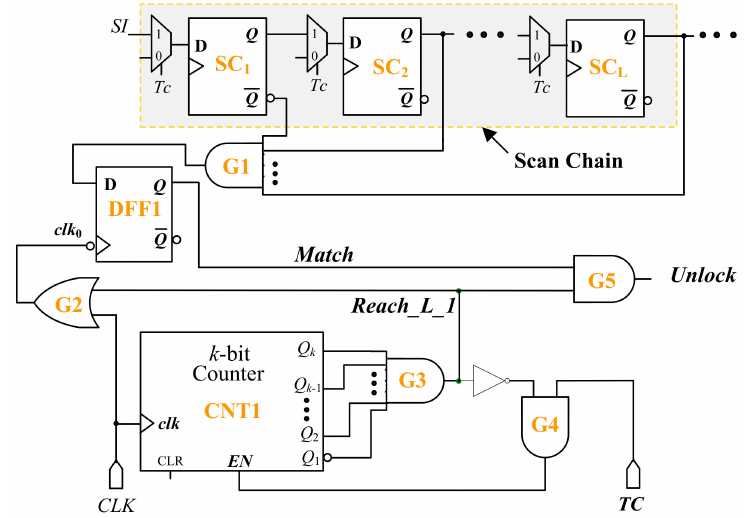
Figure 8. Test authorization